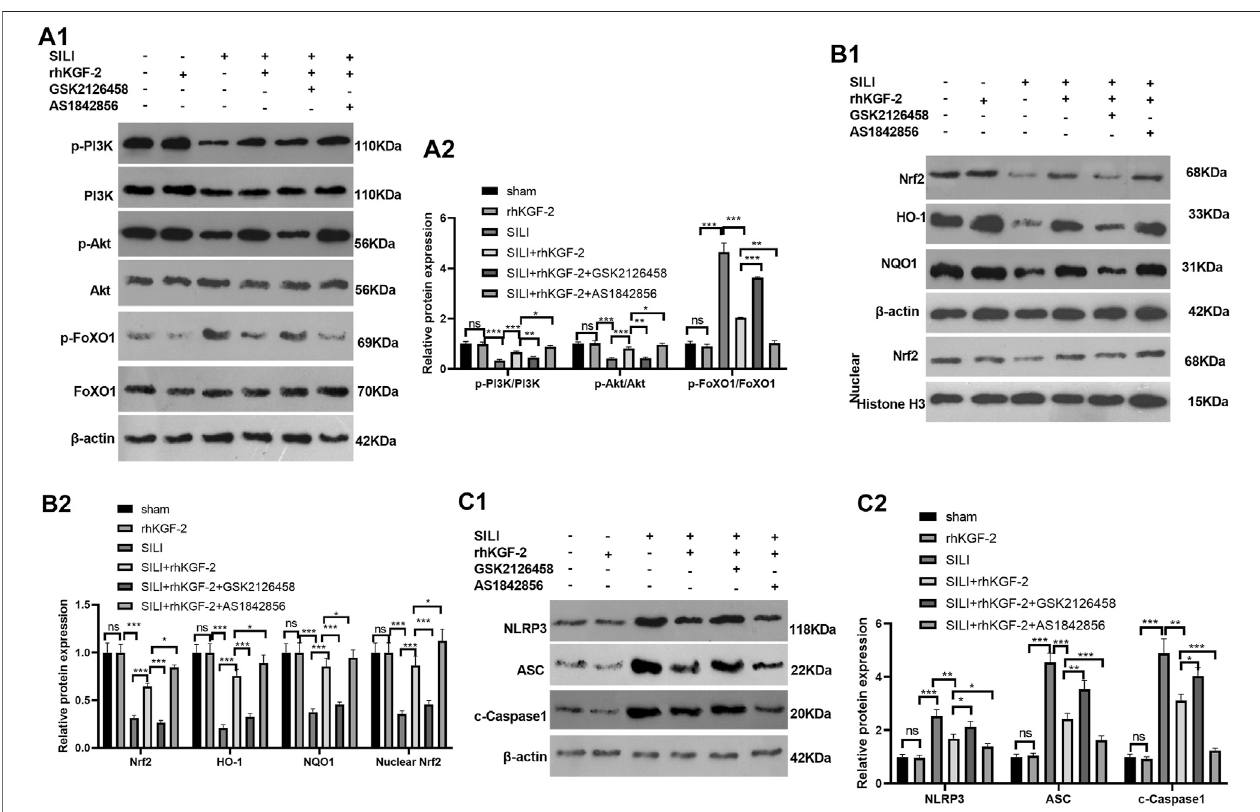
FIGURE7| rhKGF-2 has aroleinregulatingthe activation ofPI3K/Akt pathway, Nrf2/HO-1/NQO1pathway and FoxO1-NLRP3-ASC-Caspase1 in fl ammasome in vivo. The SILI rat model was established by inhalation of smoke. Then, rhKGF-2 (10 ng/kg body weight), GSK2126458 (300 μ g/kg body weight) and AS1842856 (10 μ g/kg body weight) were used for were used for treating the SILI rats, the same volume of saline was administered on the rat in the sham group. Left lung tissues of rats in each group were collected for detection. A1-A2 : WB was carried out to determine the expression of PI3K/Akt and FoxO1 in the lung tissues. B1-B2 . The proteinlevelsofNrf2,HO-1andNQO1inthelungtissues.ornuclearweredetectedbyWB.NuclearNrf2wascalculatedusingHistoneH3asinternalcontrol. C1-C2 .WB was conducted to detect NLRP3-ASC-Caspase1 in the lung tissues. The relative protein expression ( Y -axis) was calculated as fold change of sham group. Data are expressed as mean ± SD. All experiments were repeated for three times. Data difference was analyzed via ANOVA, and Student ’ s t test. NS P ＞ 0.05, * p ＜ 0.05, ** p ＜ 0.01, *** p ＜ 0.001. Five rats were involved in each group (N (cid:2) 5).